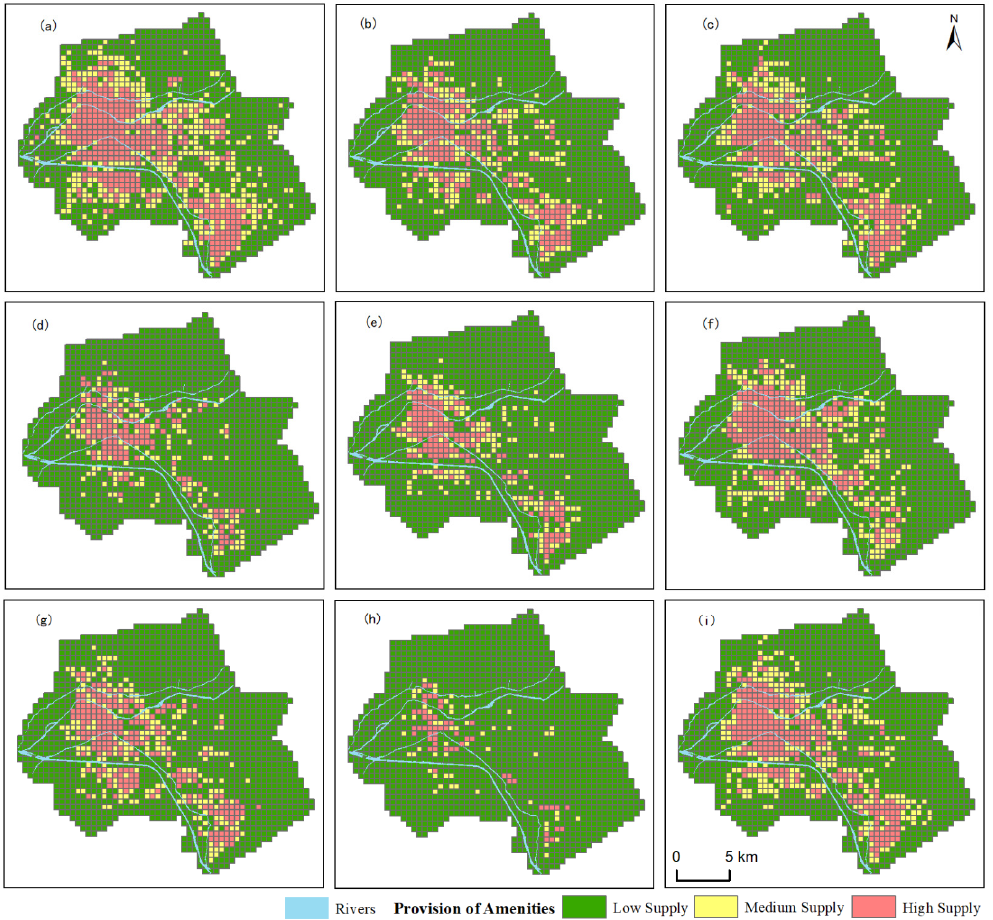
Figure 3. Spatial distributions of supply levels of different types of amenities. ( a ) the Distribution of supply levels for all amenities; ( b ) the Distribution of supply levels for amenities of Food; ( c ) the Distribution of supply levels for amenities of Shopping; ( d ) the Distribution of supply levels for amenities of Leisure; ( e ) the Distribution of supply levels for amenities of Health; ( f ) the Distribution of supply levels for amenities of Transportation; ( g ) the Distribution of supply levels for amenities of Education; ( h ) the Distribution of supply levels for amenities of Finance; ( i ) the Distribution of supply levels for amenities of life services.